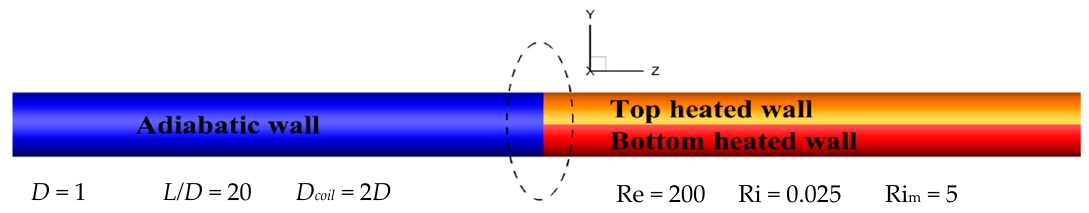
Figure 1. The studied case with characteristic dimensionless parameters. Table 1. Exemplary dimensional system and fluid properties for Pr = 0.7 (air) and Ri m = 5. Property